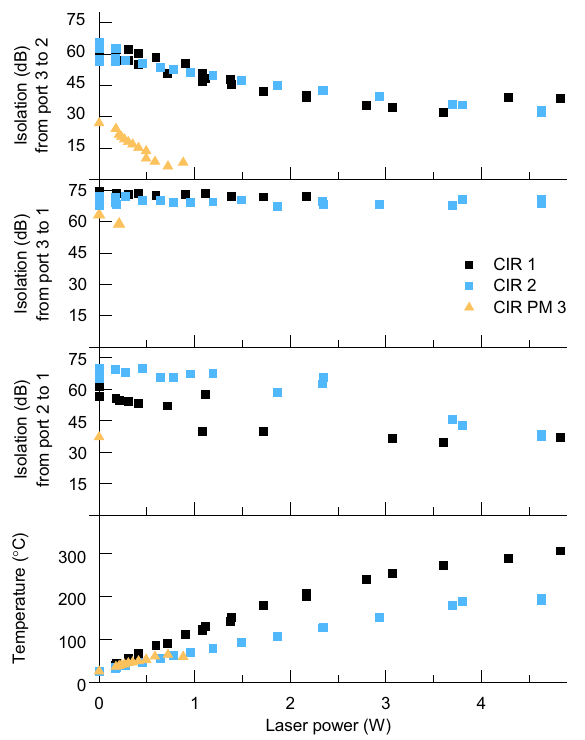
FIG. 5. Circulators’ values of isolation and the maximum surface temperature under testing. Each point represents the minimum isolation achieved under each applied power.